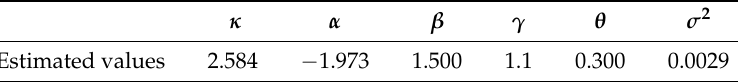
Table 1. Results for simulated Gaussian oscillabolastic diffusion.